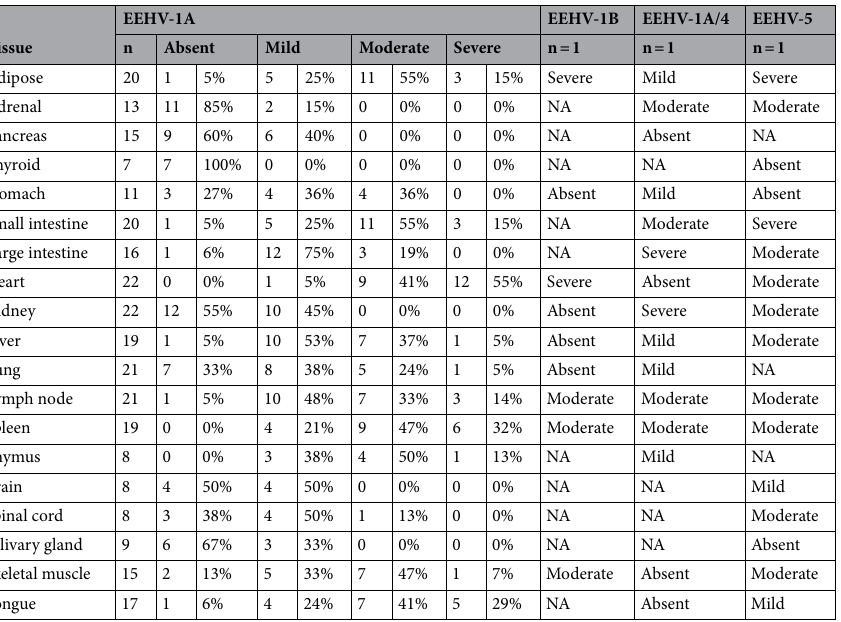
Table 1. Histological haemorrhage scores of organs from Asian elephant endotheliotropic herpesvirus- haemorrhagic disease fatalities in Europe. NA; tissue not